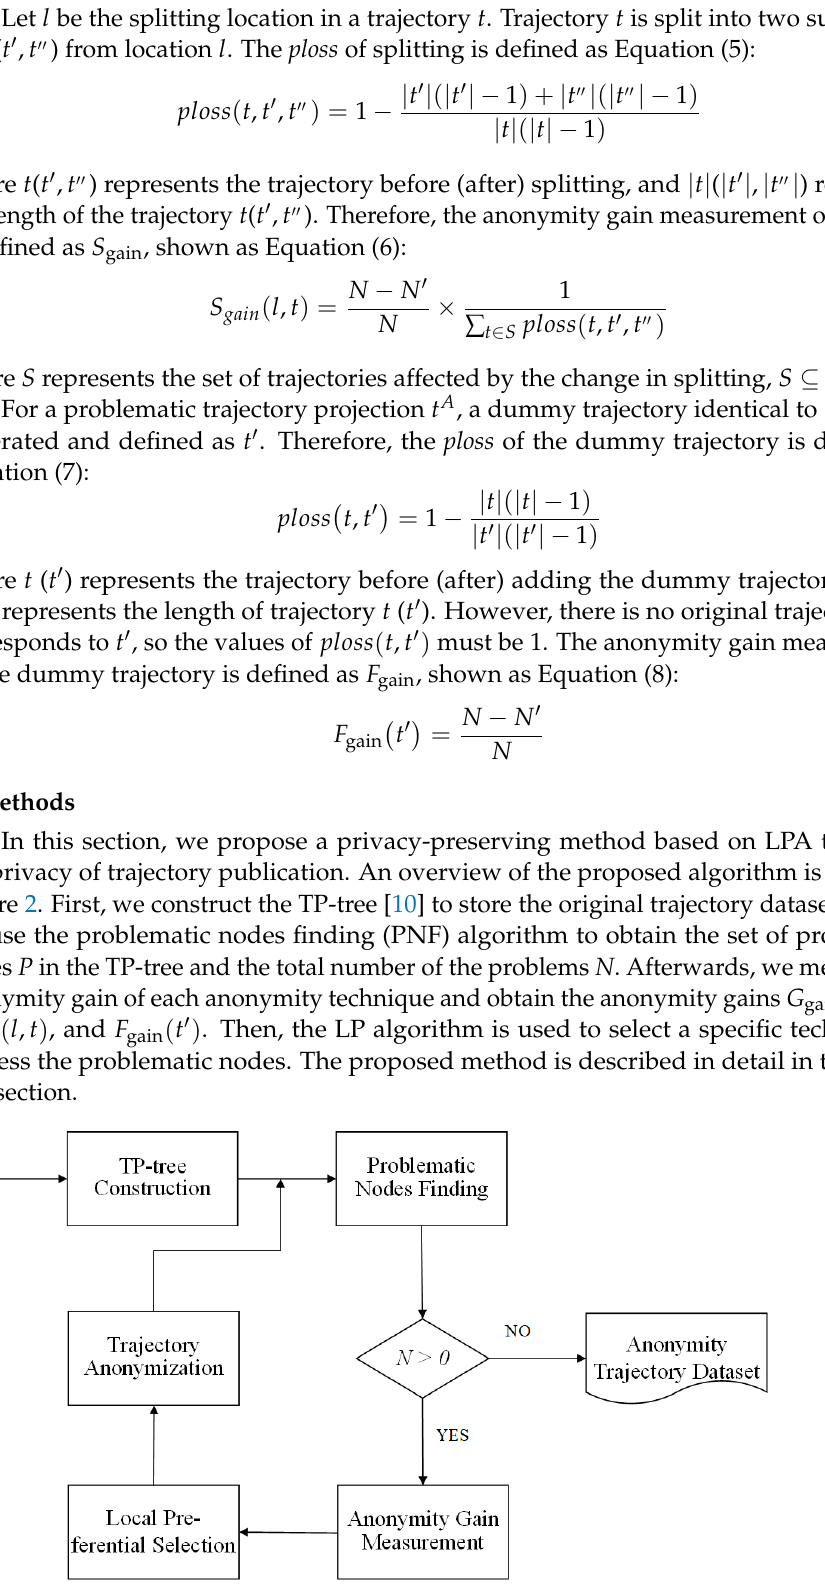
Figure 2. Overview of the proposed methods (LPA). N is the total number of problems.